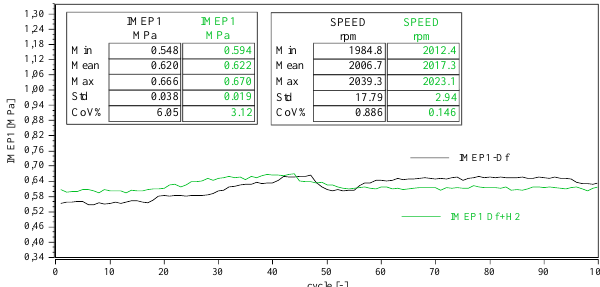
Fig. 7. Engine idle running, diesel fuelled, with the addition of hydrogen, Fig. 11. A vehicle driving with engine rotational speed of about 2000 rpm The courses of developing heat (Q1) and amount of developed heat (I1), in the fourth gear, with diesel fuel with the addition of hydrogen; The mean indexed pressure (IMEP1) are presented courses of developing heat (Q1) and amount of developed heat (I1), mean indicator pressure (IMEP1) are presented